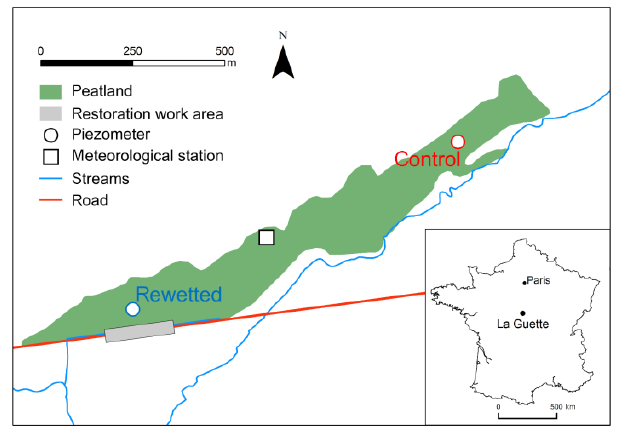
Figure 1. Location and settings of the study area. Locations of con- trol and rewetted monitoring are